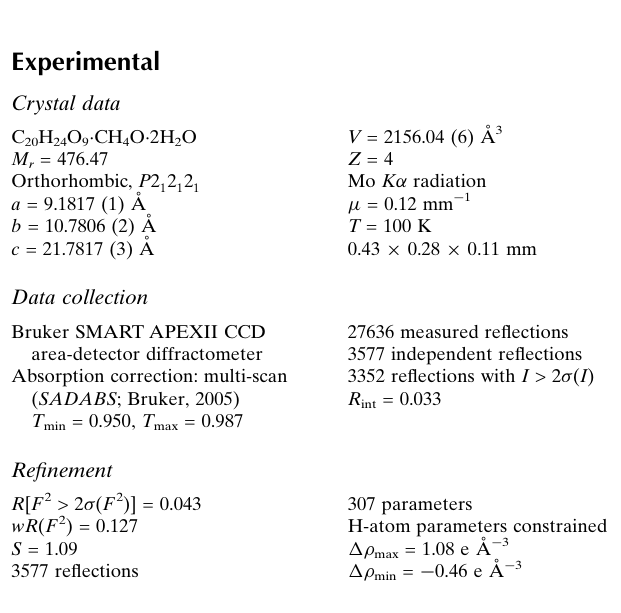
27636 measured reflections 3577 independent reflections 3352 reflections with I > 2 (cid:1) ( I ) R